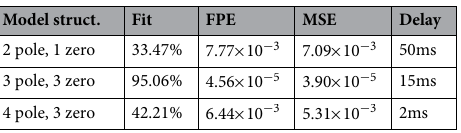
Table 2. Model candidates and performance for an example insect.